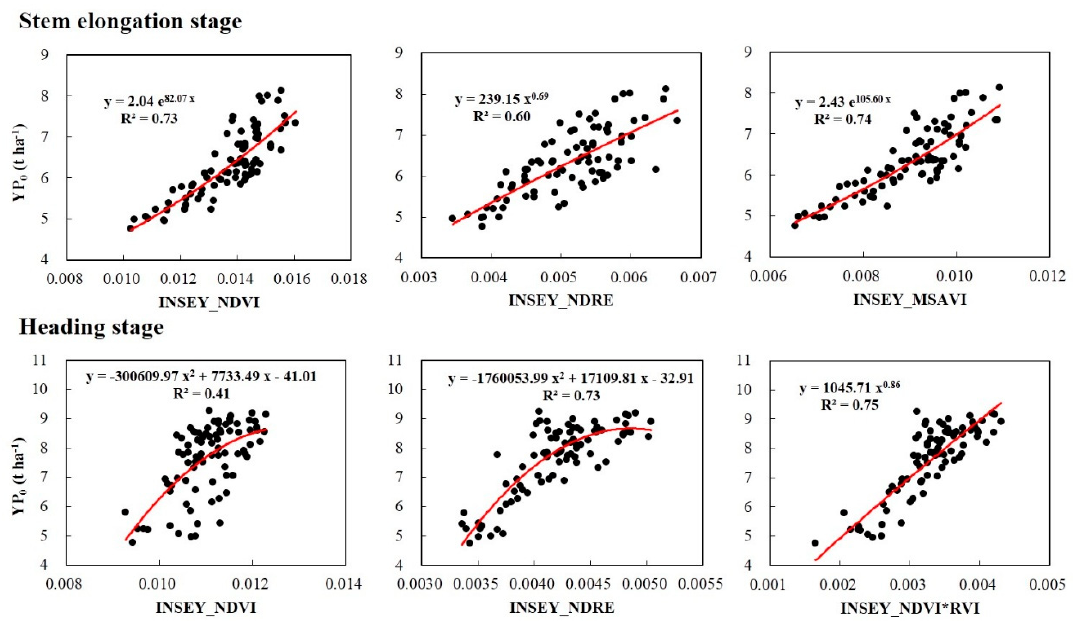
Figure 2. The relationships between yield without additional topdressing N application (YP 0 ) and in-season estimate of yield (INSEY) calculated with NDVI, NDRE, MSAVI, and NDVI*RVI across all varieties at stem elongation stage and heading stage.